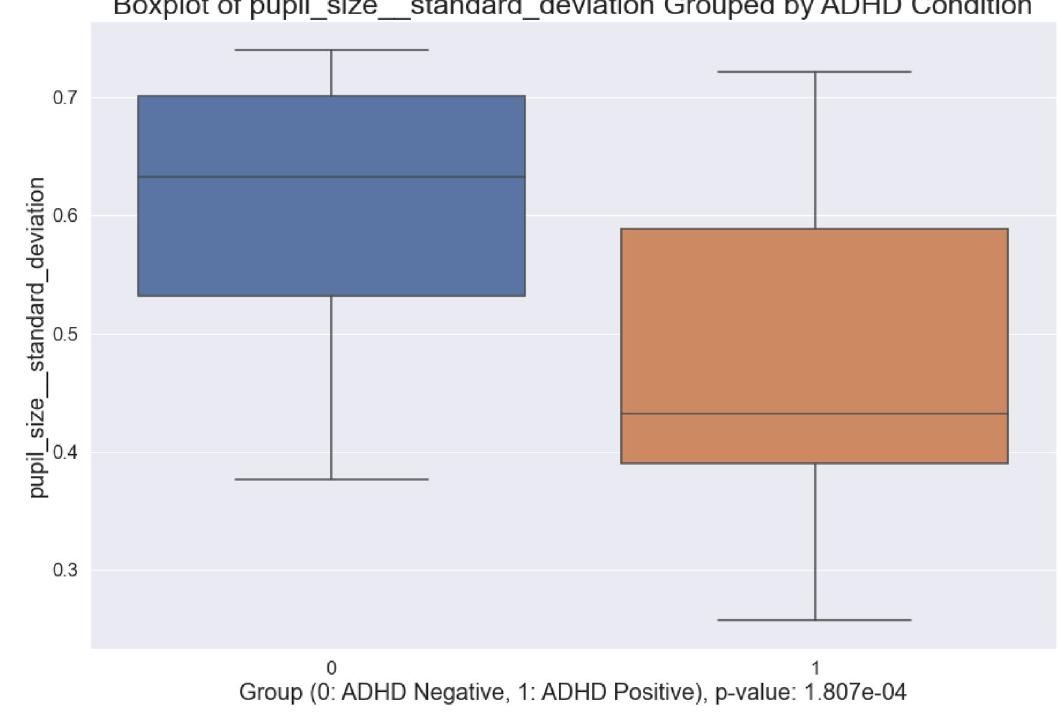
Figure 6. Box plot of pupil-size standard